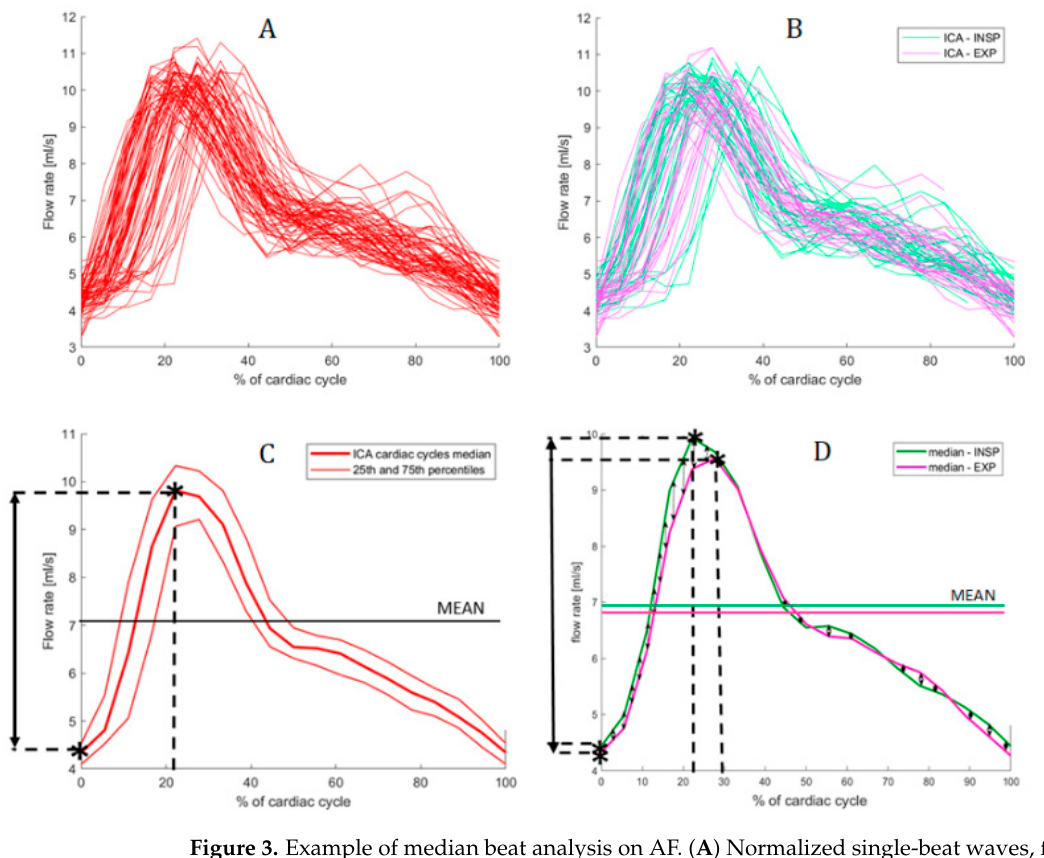
Figure 3. Example of median beat analysis on AF. ( A ) Normalized single-beat waves, from diastole to diastole. ( B ) Normalized single-beat waves during inspiration (represented in light cyan) and normalized single-beat waves during the expiration phase (represented in magenta). ( C ) Median beat and quartiles computed considering all single-beat waves, independently of breathing phase. ( D ) Median curve computed for inspiration (INSP, cyan) and expiration (EXP, magenta) median beats separately. Peak-to-peak amplitudes are highlighted in both C and D panels. The represented plots were computed from the MRI data of the same subject represented in Figure 1.